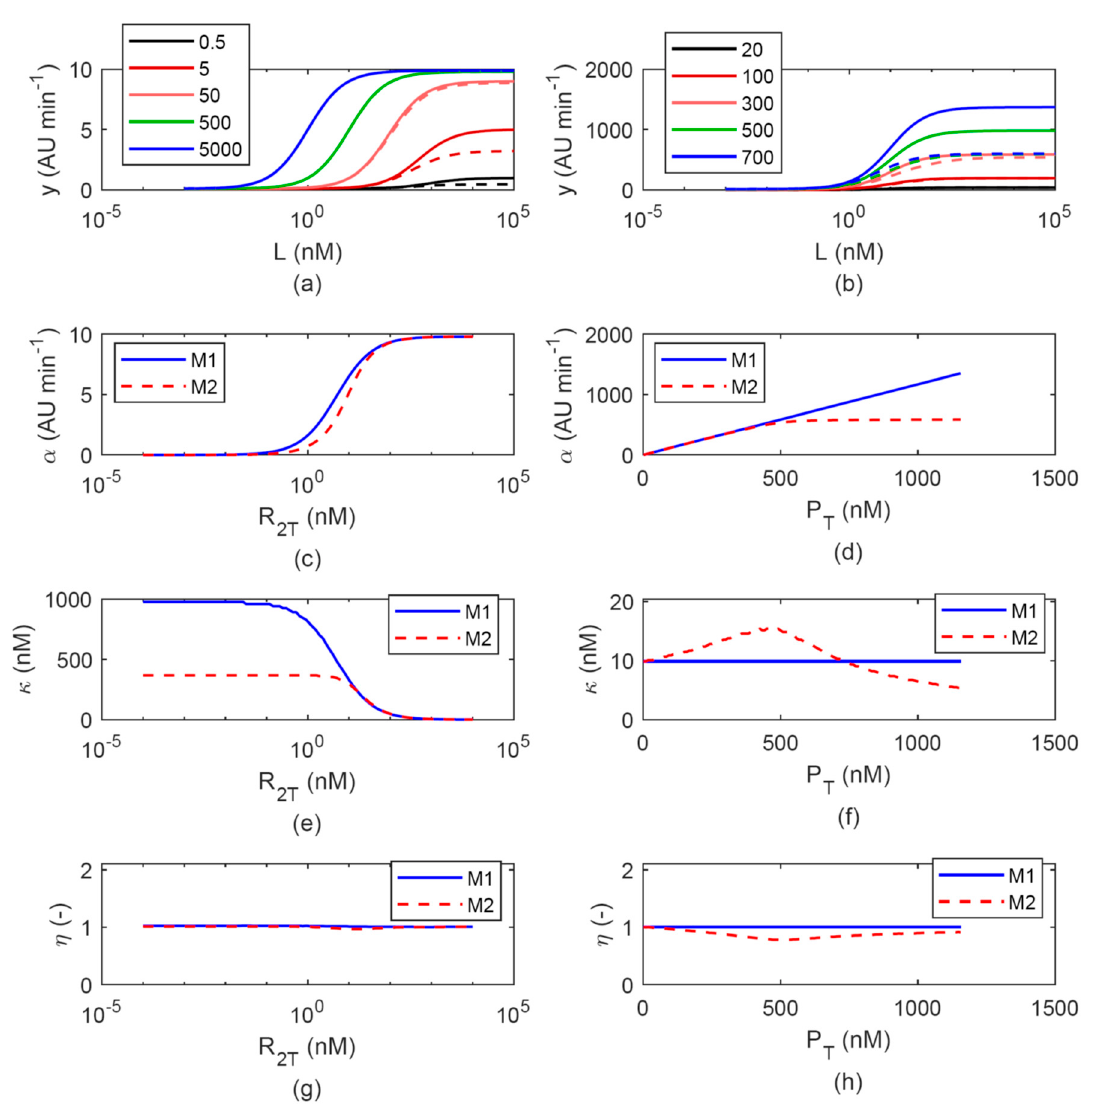
Figure 2. Comparison between M1 and M2. Panels ( a , b ) report the output activation curves of M1 (solid lines) and M2 (dashed lines) for different values of R 2T (panel ( a ), as indicated in the legend, expressed as nM) and P T (panel ( b ), as indicated in the legend, expressed as per cell copy number). The ( c )–( d ), ( e )–( f ), and ( g )–( h ) panel pairs report the R 2T - and P T -dependent trend of α , κ and η , respectively, with solid and dashed lines representing M1 and M2, respectively. In panels ( a , c , e , g ) the promoter copy number value was set to 5, while in panels ( b , d , f , h ) the LuxR concentration was set to 500 nM.